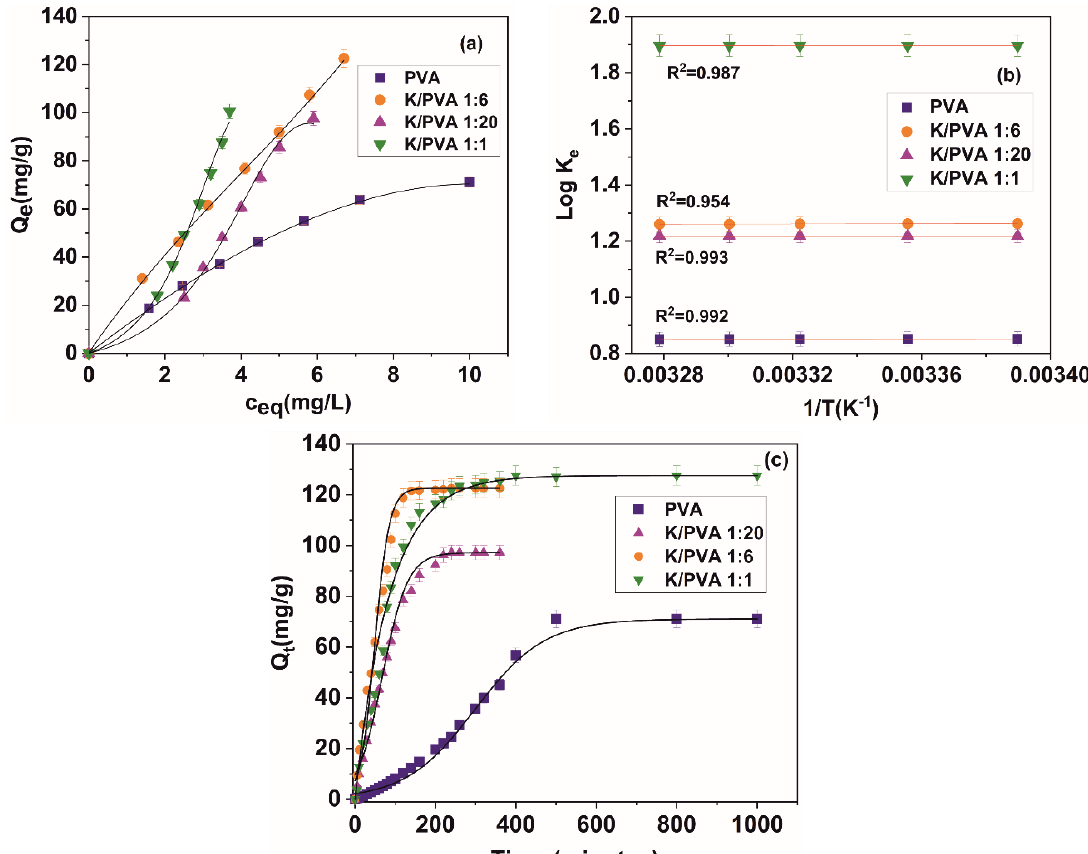
Figure 9. ( a ): Adsorption isotherms for CV onto the PVA/CAR hydrogels at 25 °C; ( b ): van’t Hoff plots and ( c ): kinetic for the CV sorption in the PVA/CAR hydrogels at 25 °C. Table 5. Parameters of the isotherm models fitted onto the experimental CV adsorption data at 25 °C.